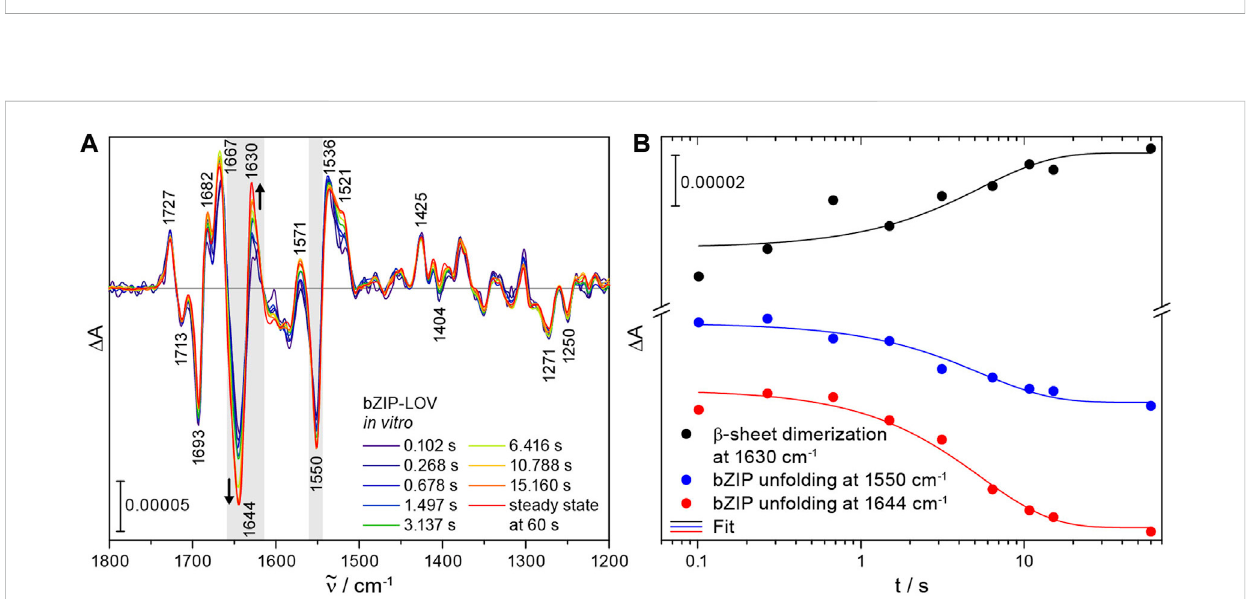
FIGURE 3 Time-resolved FTIR difference spectra of bZIP-LOV from Pt Aureo1a and kinetics of selected secondary structure elements highlighted in gray. (A) Theseriesofdifferencespectraafterlaserexcitationat355 nmshowsdistinctchangesinsecondarystructureelementsat1644( − ) cm − 1 and1630(+) cm − 1 in the millisecond to second time range. For comparison, a steady-state spectrum was taken from [22] and scaled at 1727 cm − 1 . (B) Kinetic analysis was performed of the characteristic signals at 1630 (+) cm − 1 (mean absorbance from 1632 to 1622 cm − 1 ) and 1644 ( − ) cm − 1 (mean absorbance from 1647 to 1636 cm − 1 ) assigned to formation of the light state dimer of LOV via β -sheet dimerization and to α -helix unfolding of the bZIP, respectively. The partial unfolding of bZIP is also observed in the corresponding amide II region at 1550 cm − 1 (mean absorbance from 1553 to 1545 cm − 1 ). A monoexponential global fi t reveals a time constant of τ = 5 (± 1) s for β -sheet dimerization and bZIP